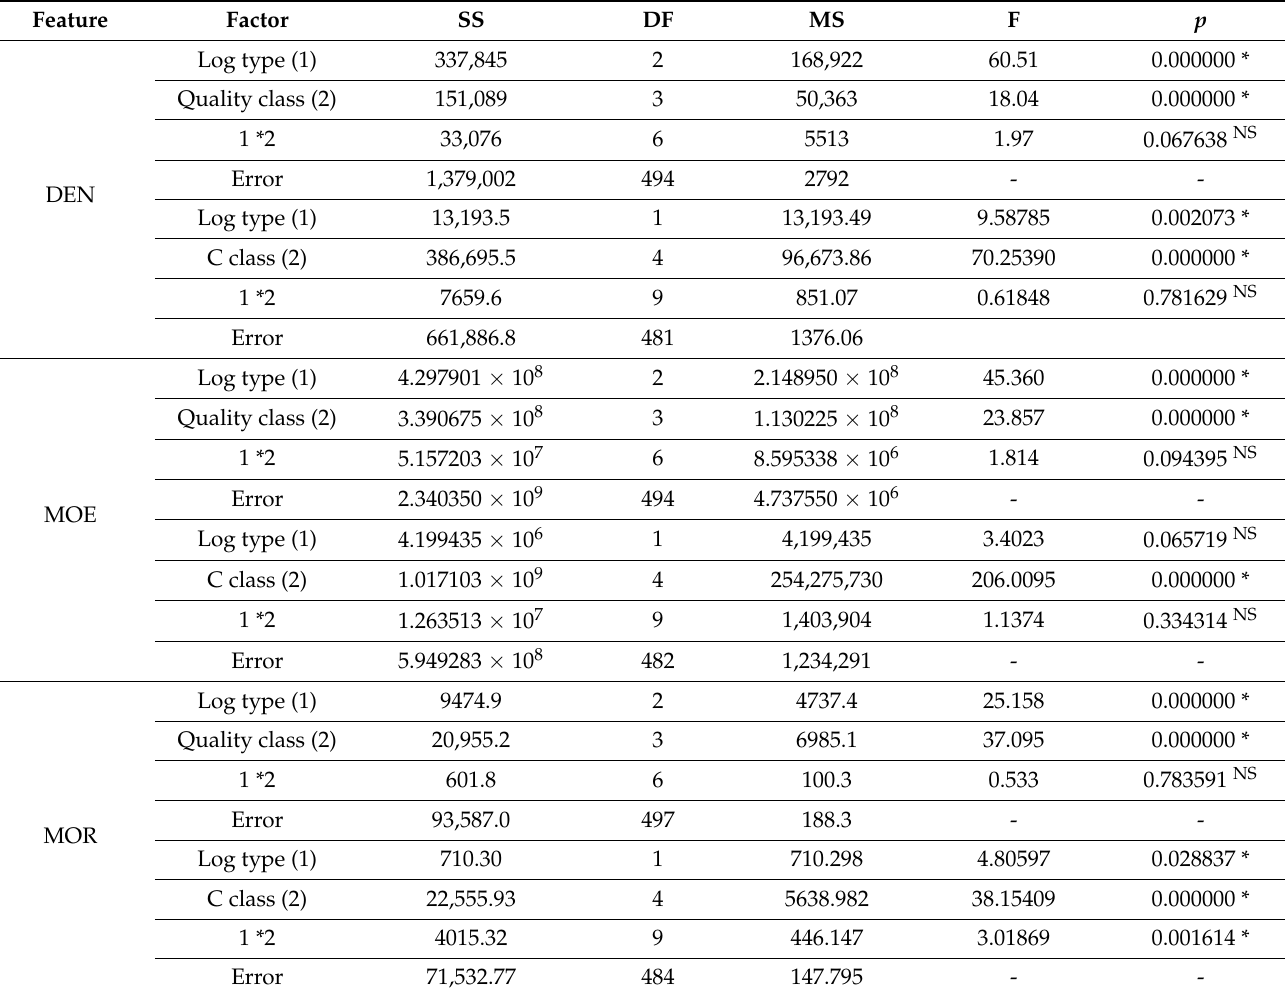
Table 2. Values of ANOVA for density, MOE and MOR, depending on the type of log, log quality, and the assigned strength